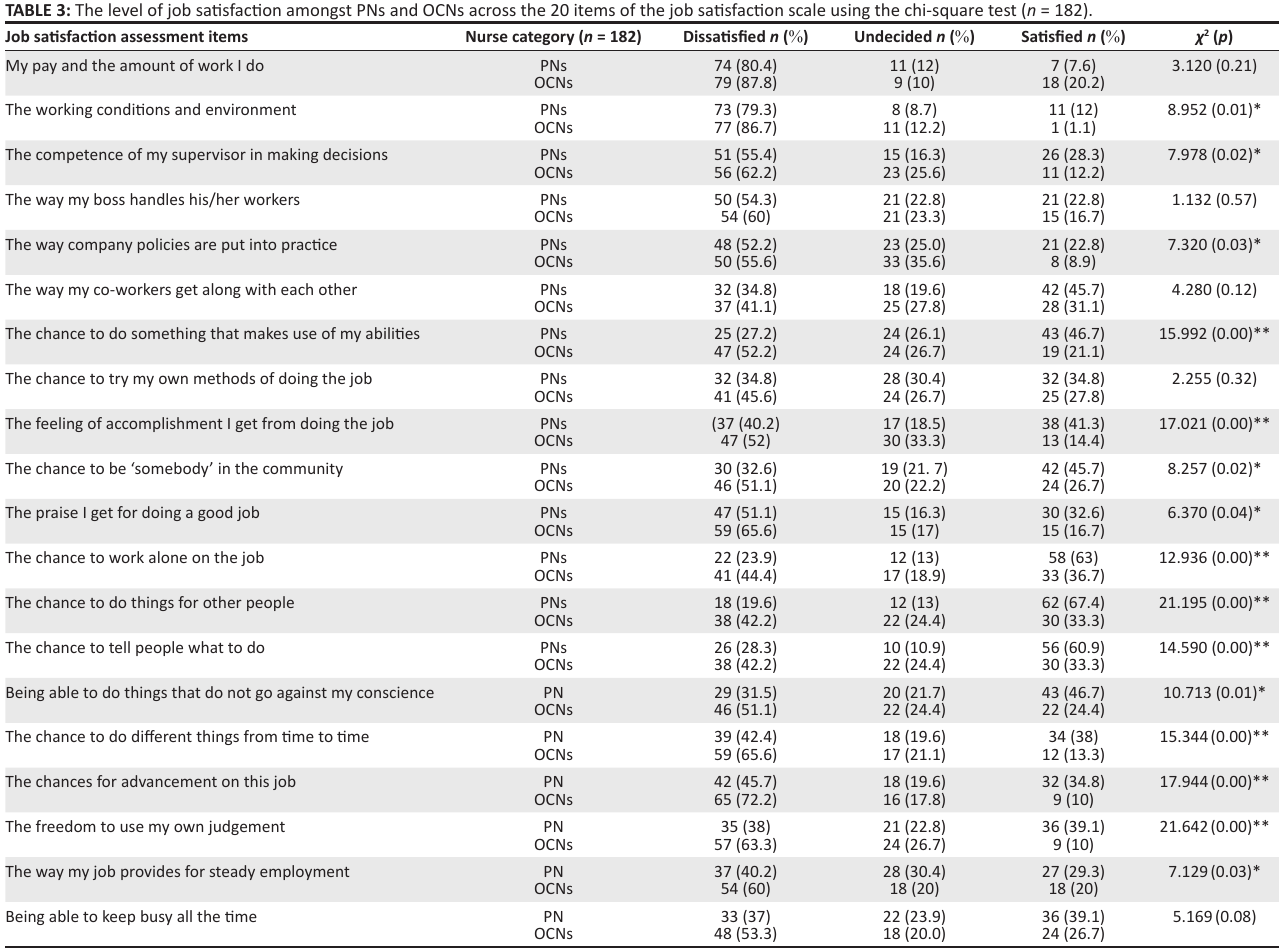
TABLE 3: The level of job satisfaction amongst PNs and OCNs across the 20 items of the job satisfaction scale using the chi-square test ( n = 182). Job satisfaction assessment